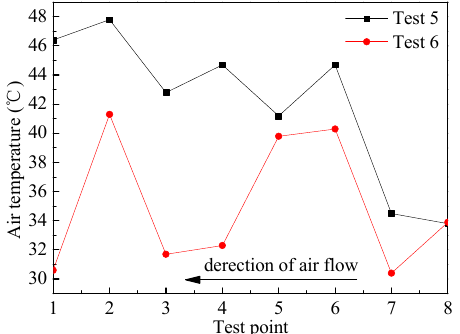
Figure 15. The trend of the air temperature along the air flow.